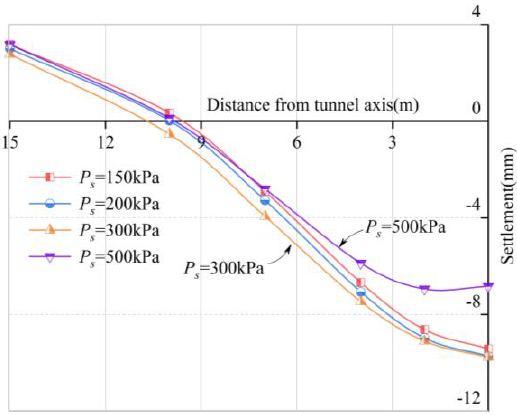
Figure 9. Influence of support pressure on the lateral deformation of the ground surface.